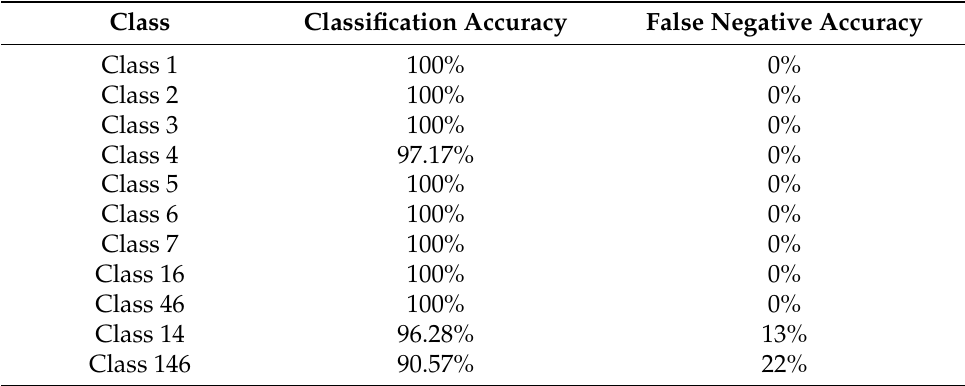
Table 6. Accuracy of single and multiple source PRPD patterns.